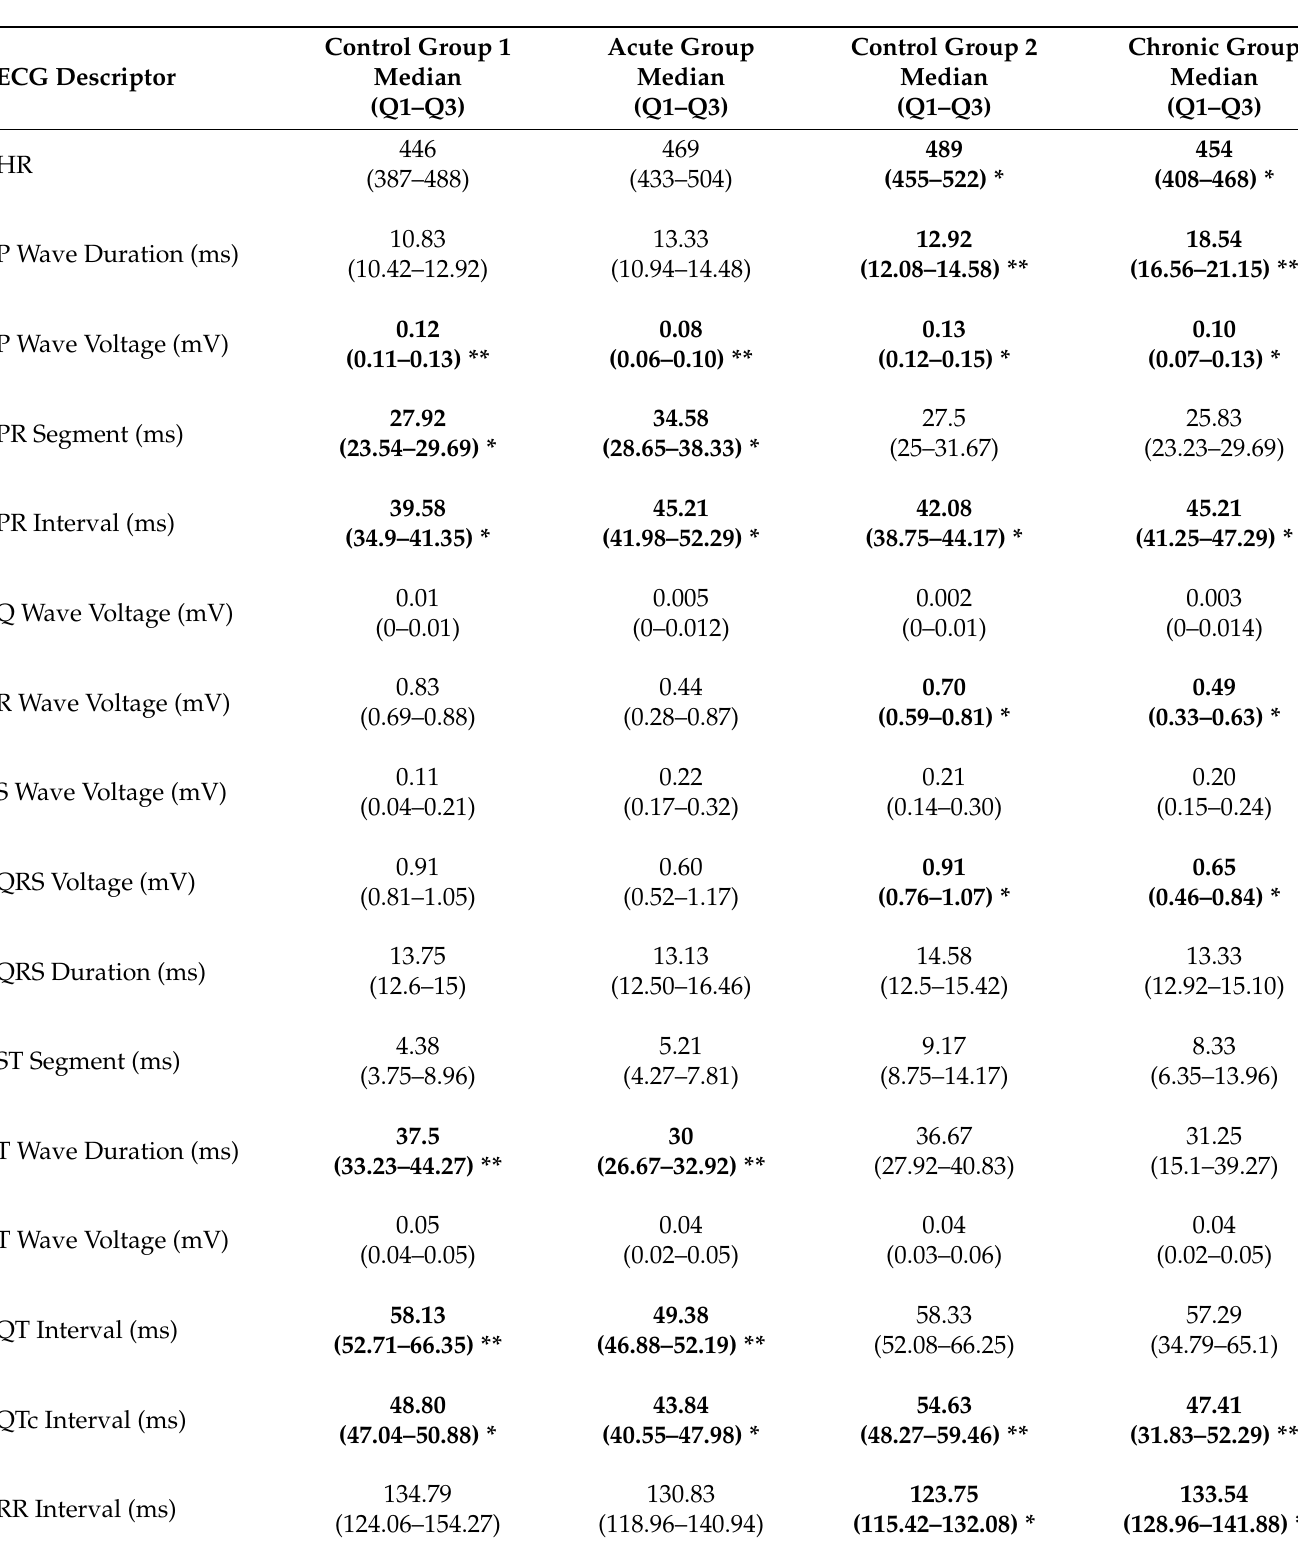
Table 2. Statistical comparisons (median and interquartile ranges) between the mice of Control 1 and the group with acute infection and between the mice of Control 2 and the group with chronic infection, for each ECG descriptor studied. Statistically significant comparisons are shown in bold (* p ≤ 0.05, ** p ≤